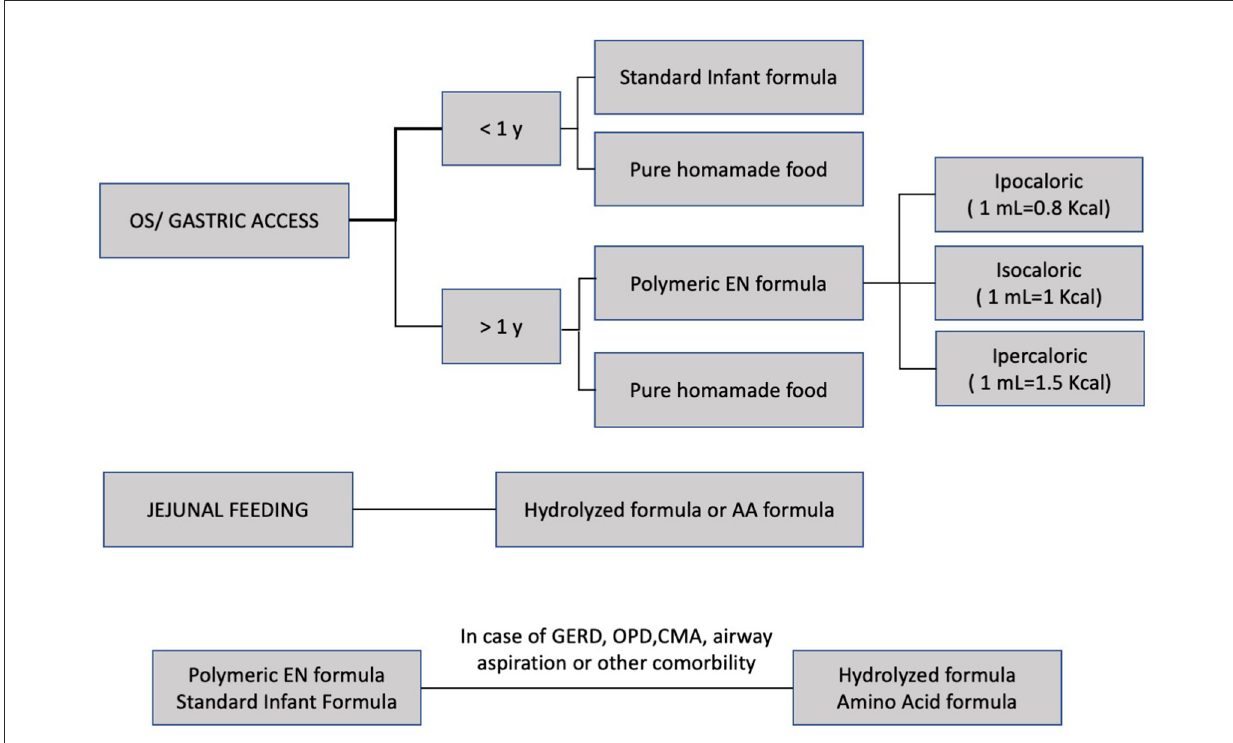
FIGURE1 EN, enteral nutrition; GERD, gastroesophageal reflux disease; CMA, Cow’s milk allergy.